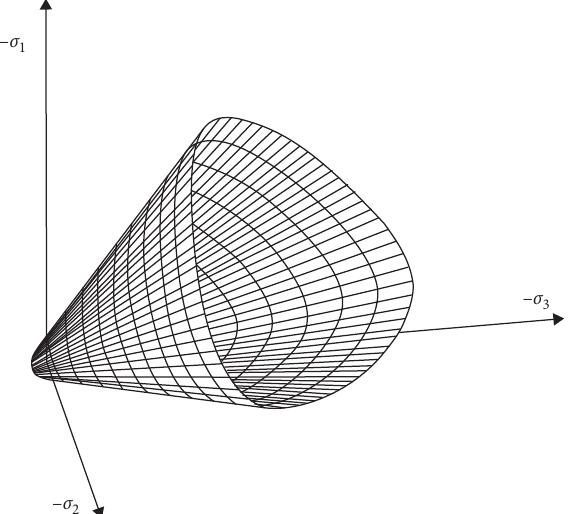
Figure 3: The typical failure surface in the principal stress space.